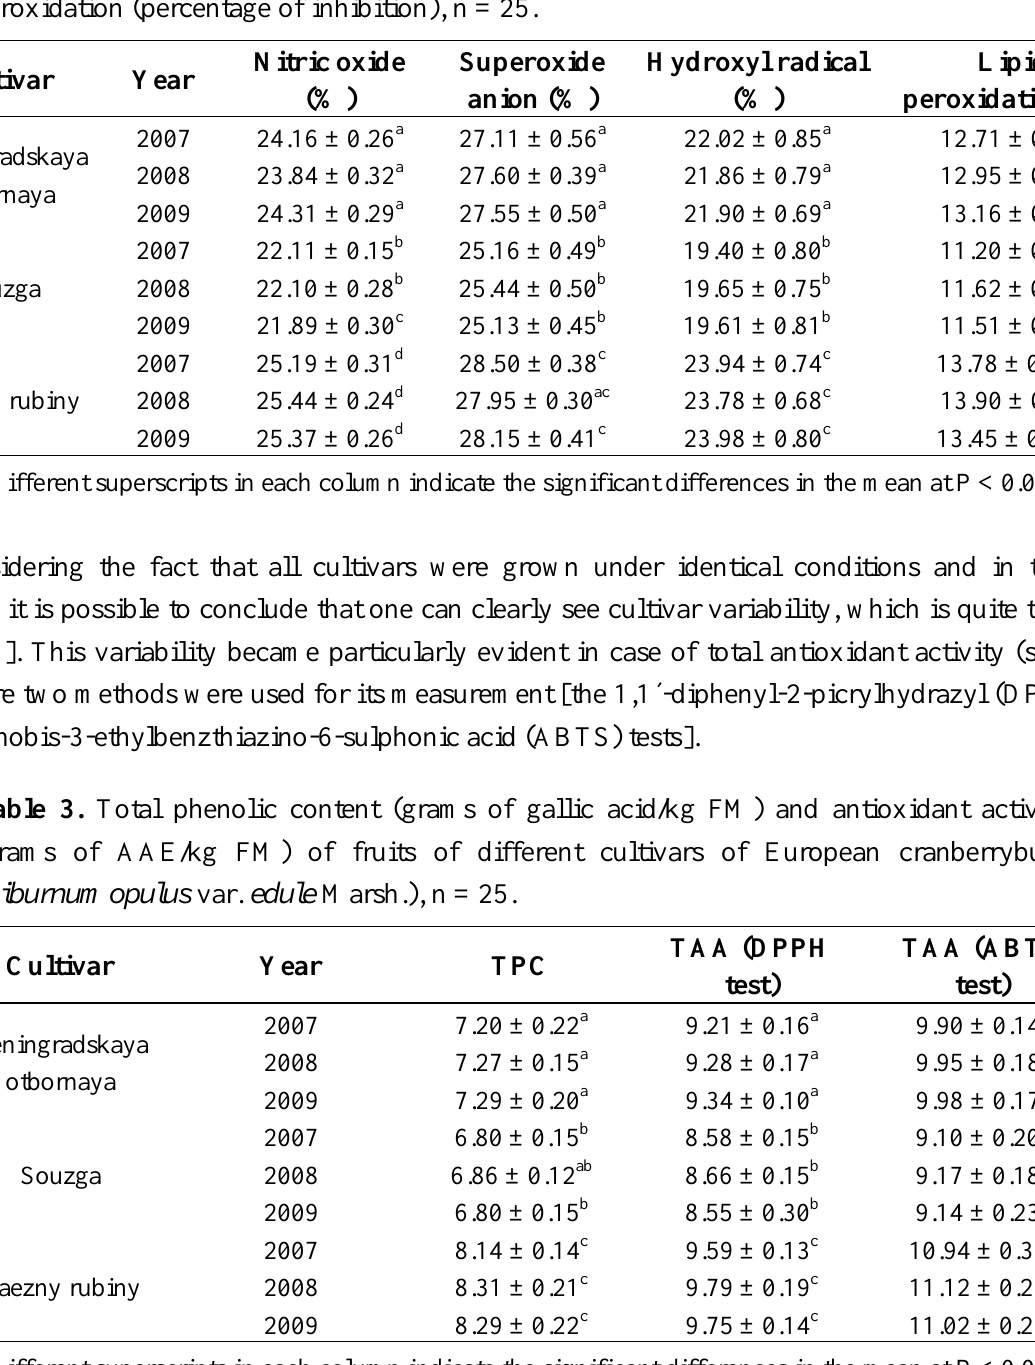
Different superscripts in each column indicate the significant differences in the mean at P <